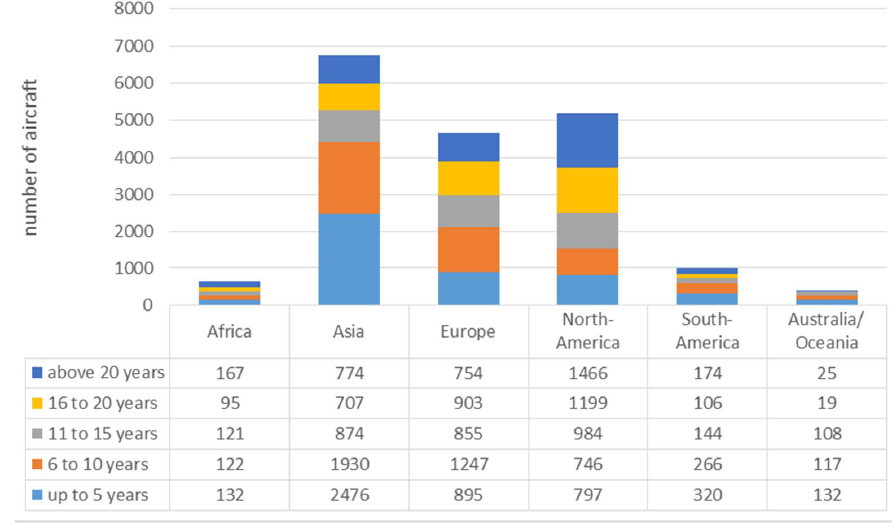
Figure 5. Operational fleet age overview (in years) per continent (total a/c number = 21.028).